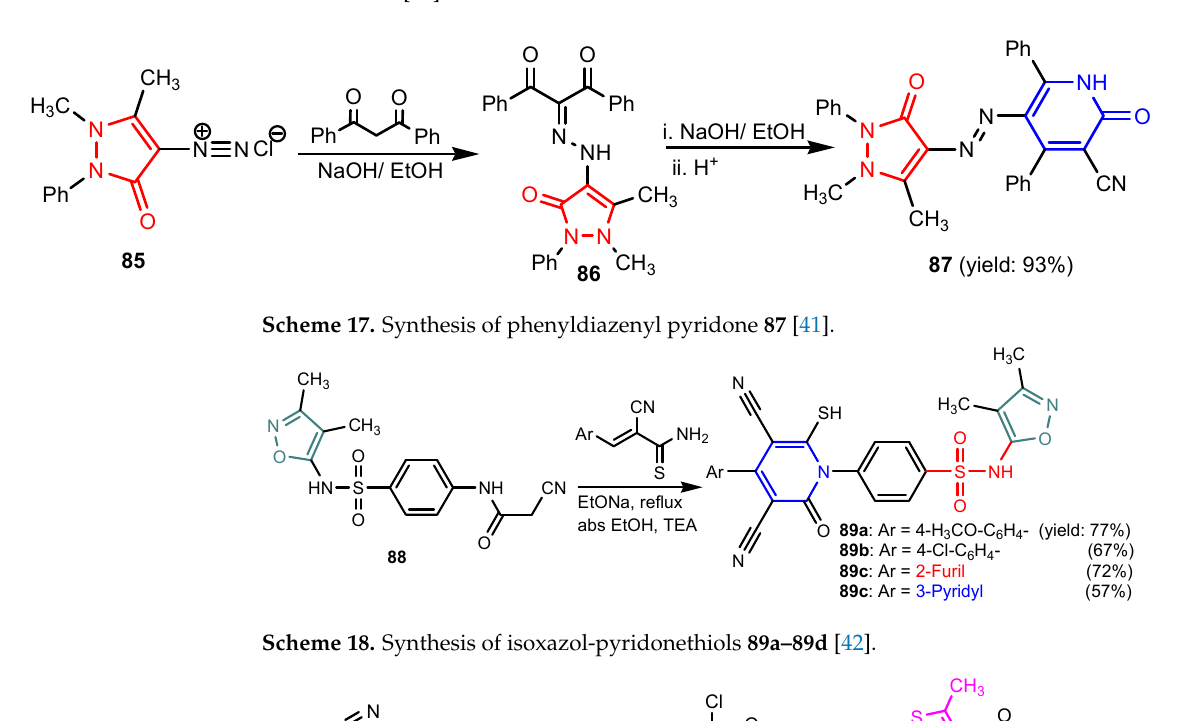
Figure 7. Docking into the active site of glucosamine-6-phosphate (GlcN-6-P) synthase (PDB ID: 2VF5). ( A ) Docked poses of compounds 82 – 84 on the GlcN-6-P; ( B ) the interaction the compound 84 and GlcN-6-P [40].